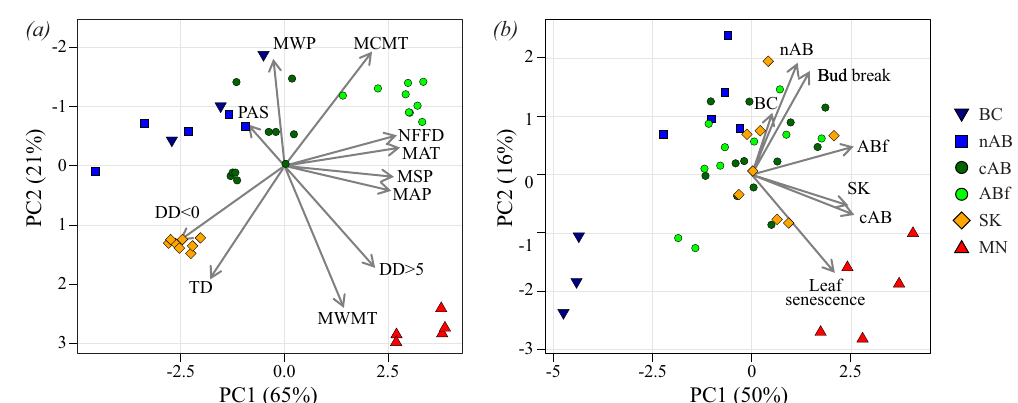
Figure 2. Principal components analyses for climate conditions at seed source locations ( a ) and multi-trait measurements in common garden trials ( b ). Vector labels represent the input variables. Symbols in ( a ) represent the geographic location of provenances; symbols in ( b ) represent the provenance collections. Vector labels in ( a ): PAS = precipitation as snow (mm), MWP = mean winter precipitation (°C), MCMT = mean coldest month temperature (°C), NFFD = number of frost free days, MAT = mean annual temperature (°C), MSP = mean summer precipitation (mm), MAP = mean annual precipitation (mm), DD > 5 = degree-days above 5 °C (growing degree-days), MWMT = mean warmest month temperature (°C), TD = temperature difference between MCMT and MWMT (or continentality, °C), DD < 0 = degree-days below 0 °C (chilling degree-days); Vector labels in ( b ): BC = height at British Columbia test site, nAB = height at northern Alberta test site, ABf = height at Alberta Foothills test site, SK = height at Saskatchewan test site, cAB = height at central Alberta test site, Bud break = timing of bud break at central Alberta test site, Leaf senescence = timing of leaf senescence at central Alberta test